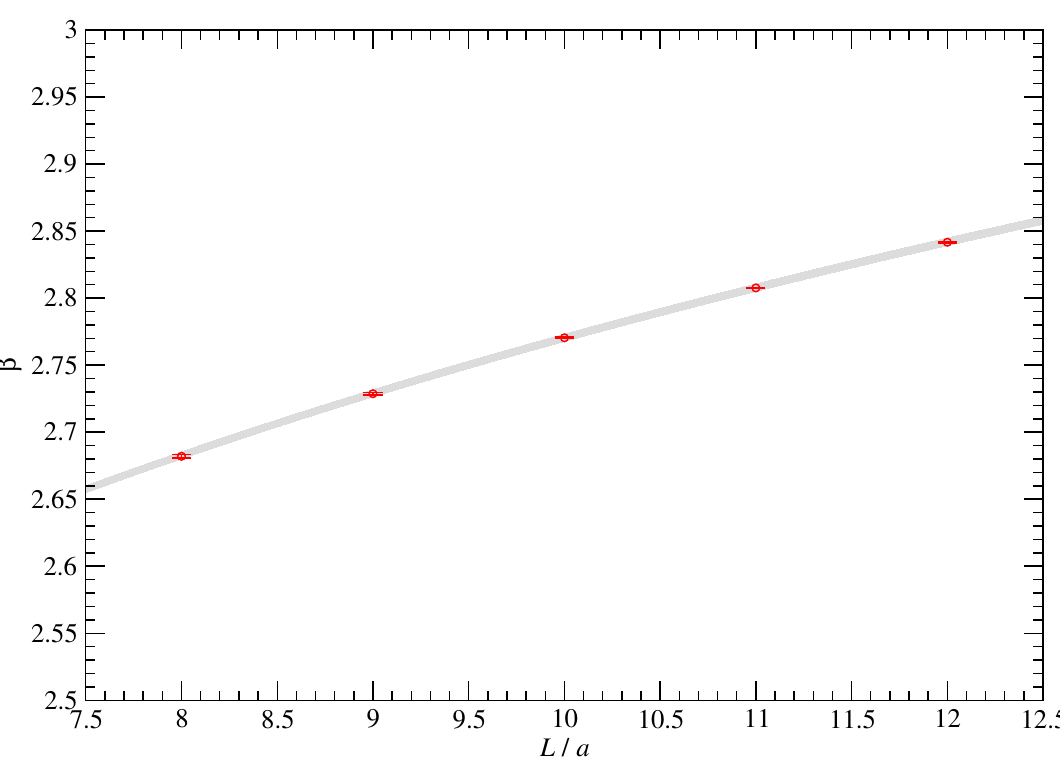
Figure 4 . The inverse-squared-bare-coupling parameter (cid:12) = 2 N=g 2 (red circles), as a function of L=a , in SU(2) Yang-Mills theory and the corresponding (cid:12)tted curve (cid:12) = 1 : 866(22) + 0 : 3928(9) (cid:1) ln( L=a ), with the associated uncertainty (gray